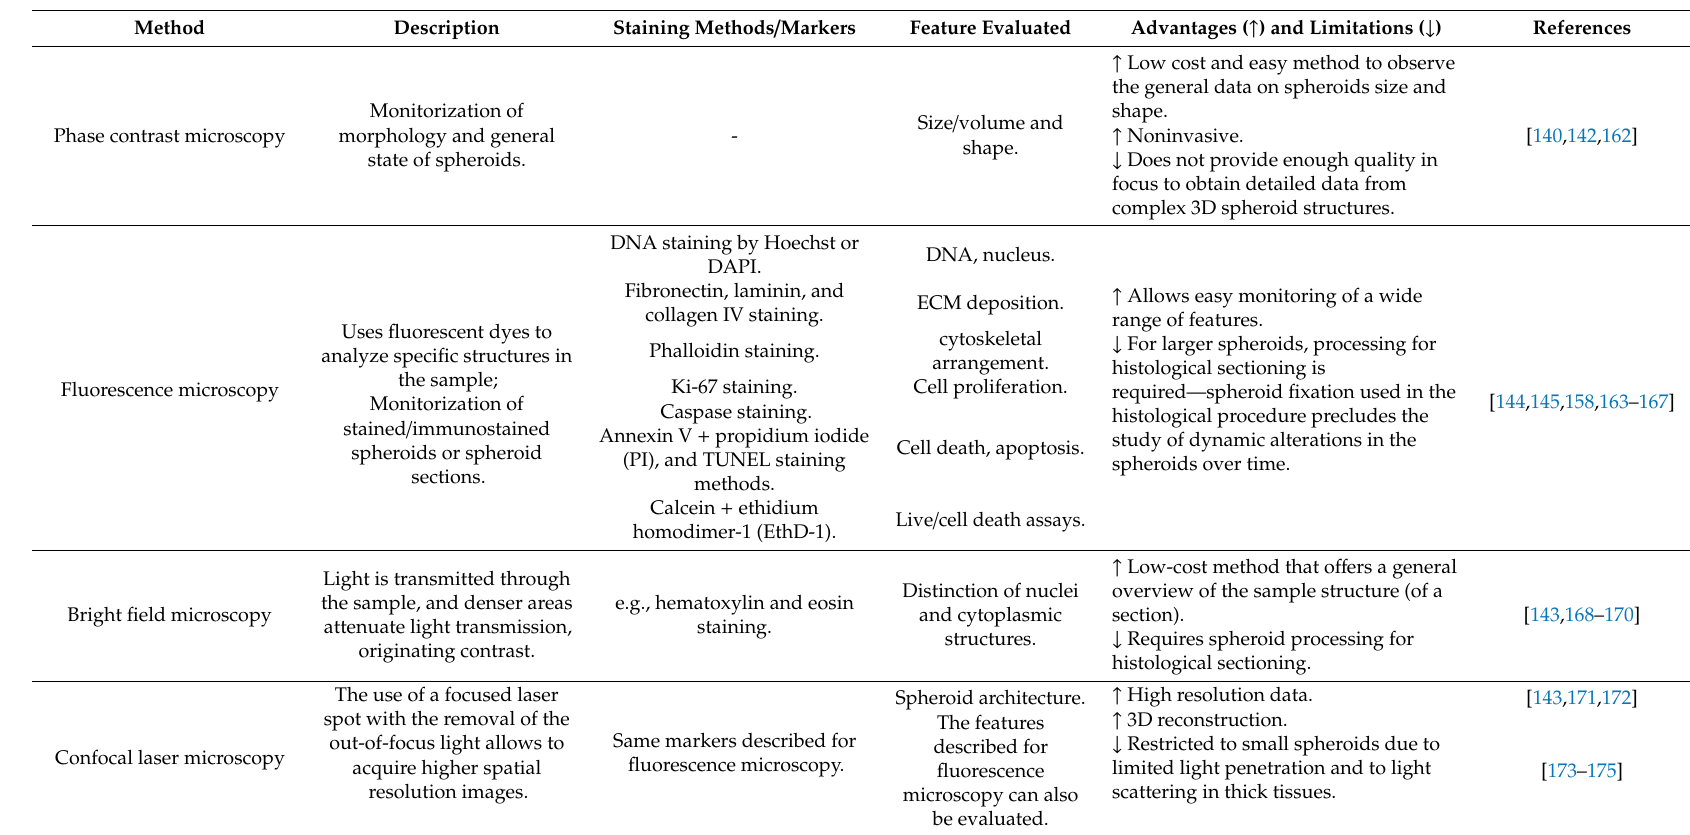
Table 4. Methods currently used to characterize spheroids and to evaluate drug e ff